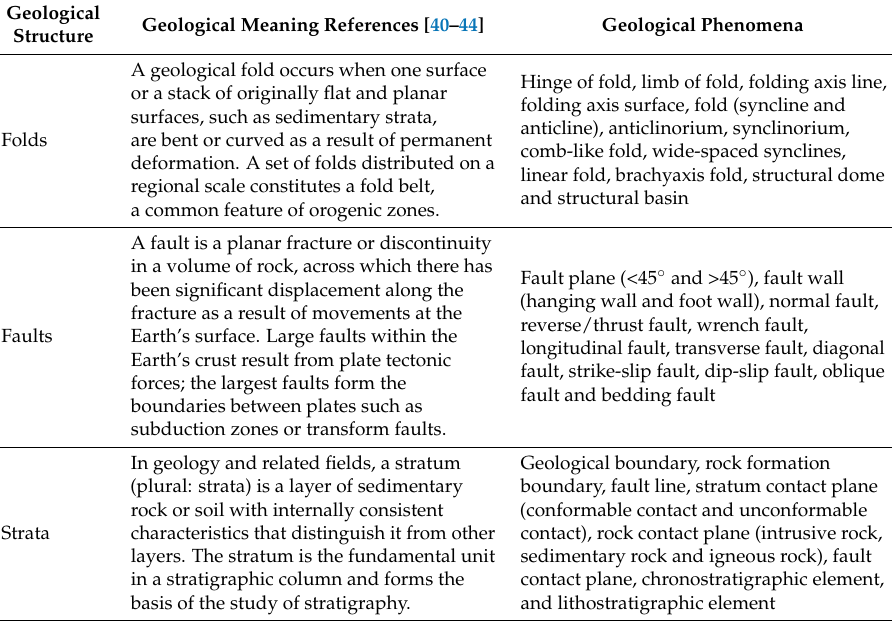
Table 1. Classification of geological phenomenon in regional geological structures.